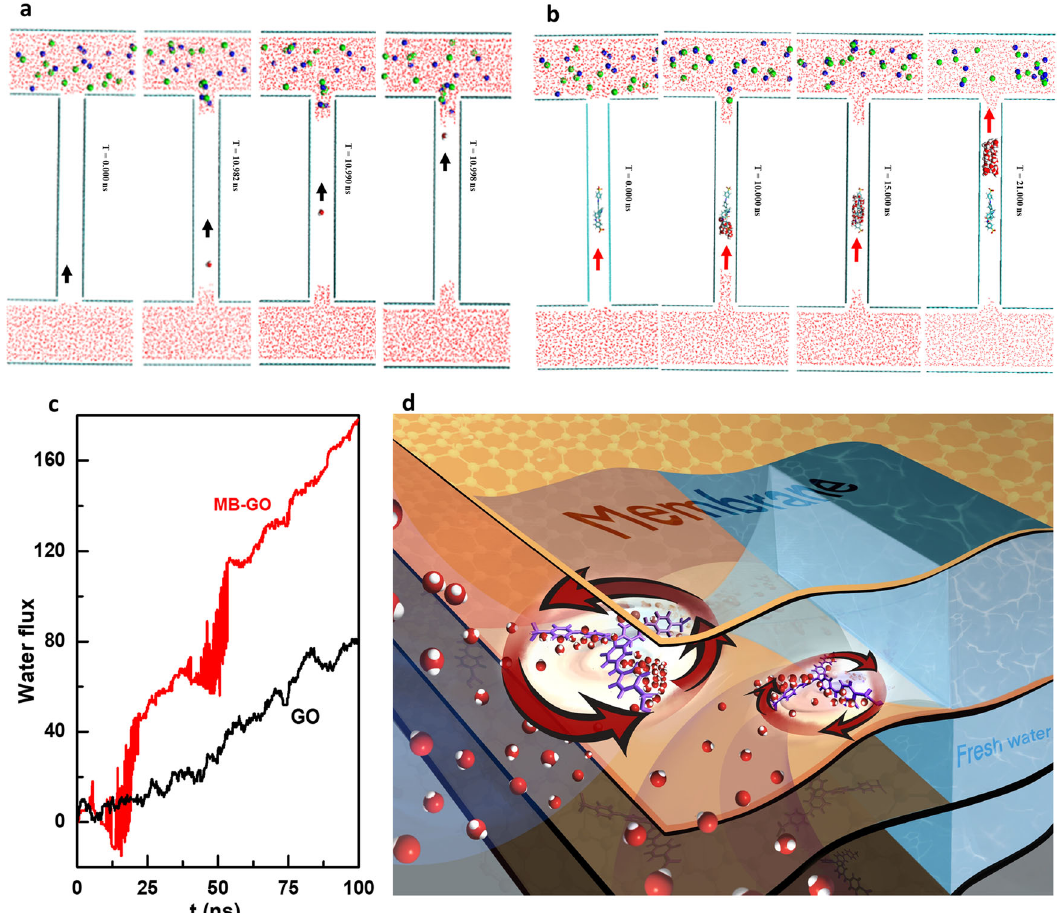
Fig. 4 Molecular dynamics simulation of water permeation through GO-based membranes. Molecular dynamics (MD) simulation snapshots of water (vapor) diffusion through a GO 2D channel ( d = 13.6 Å) at 0 to 10.998 ns and b MB-GO 2D channel ( d = 11.4 Å) at 0 to 21 ns. Na, blue; Cl, green; C, cyan; H, white; O, red; P, yellow. c Water fl uxes in MB-GO and GO systems. The simulation system consists of 0.4 mol L − 1 NaCl solution on one and pure water on the other side of two 10 nm long layers of graphene. The MB molecule was put in the middle of the graphene channel according to the quantum calculation for geometries. It generates a chemical potential gradient across the gap, which drives vapor transport from the pure water side to the salt solution side. The net water fl ux across the middle cross-section is measured. d Schematic of the pumping process on organic ions for water